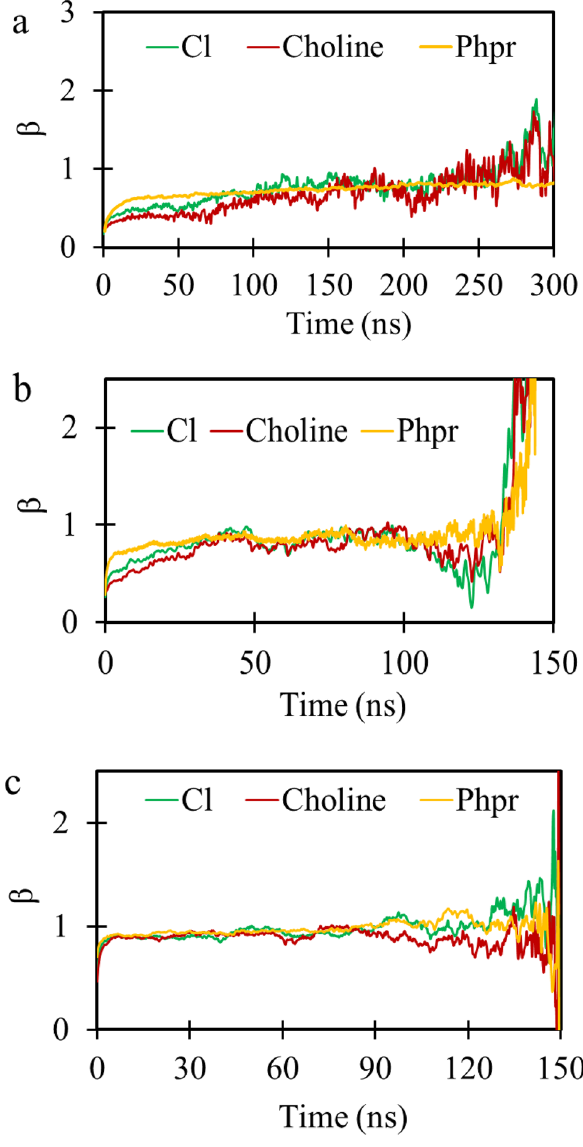
Figure 10. The variation of β with time for chloride (green), choline (red) and phenyl propionic acid (yellow) in DES were plotted by Gnuplot 5.2.6 (http:// www. gnupl ot. info/) at 293: ( a ); 321: ( b ); 400; ( c ) and in 0.1